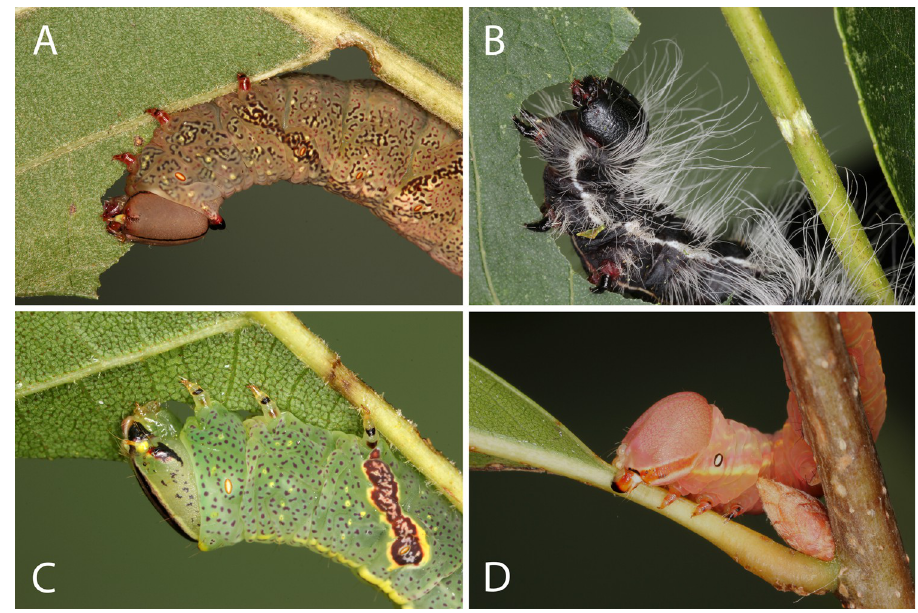
Fig 6. Furrows, girdles, and petiole crimps of final instar notodontids. (A) Heterocampa umbrata larva feeding on southern red oak ( Quercus falcata ) after chewing a furrow in the midrib. (B) Datana integerrima larva feeding on a pecan leaflet ( Carya illinoinensis ) near a girdle that it cut in the rachis. (C) Cecrita guttivitta larva feeding near a furrow in a Carya illinoinensis leaf. (D) Peridea angulosa crimping the petiole of a water oak leaf ( Quercus nigra